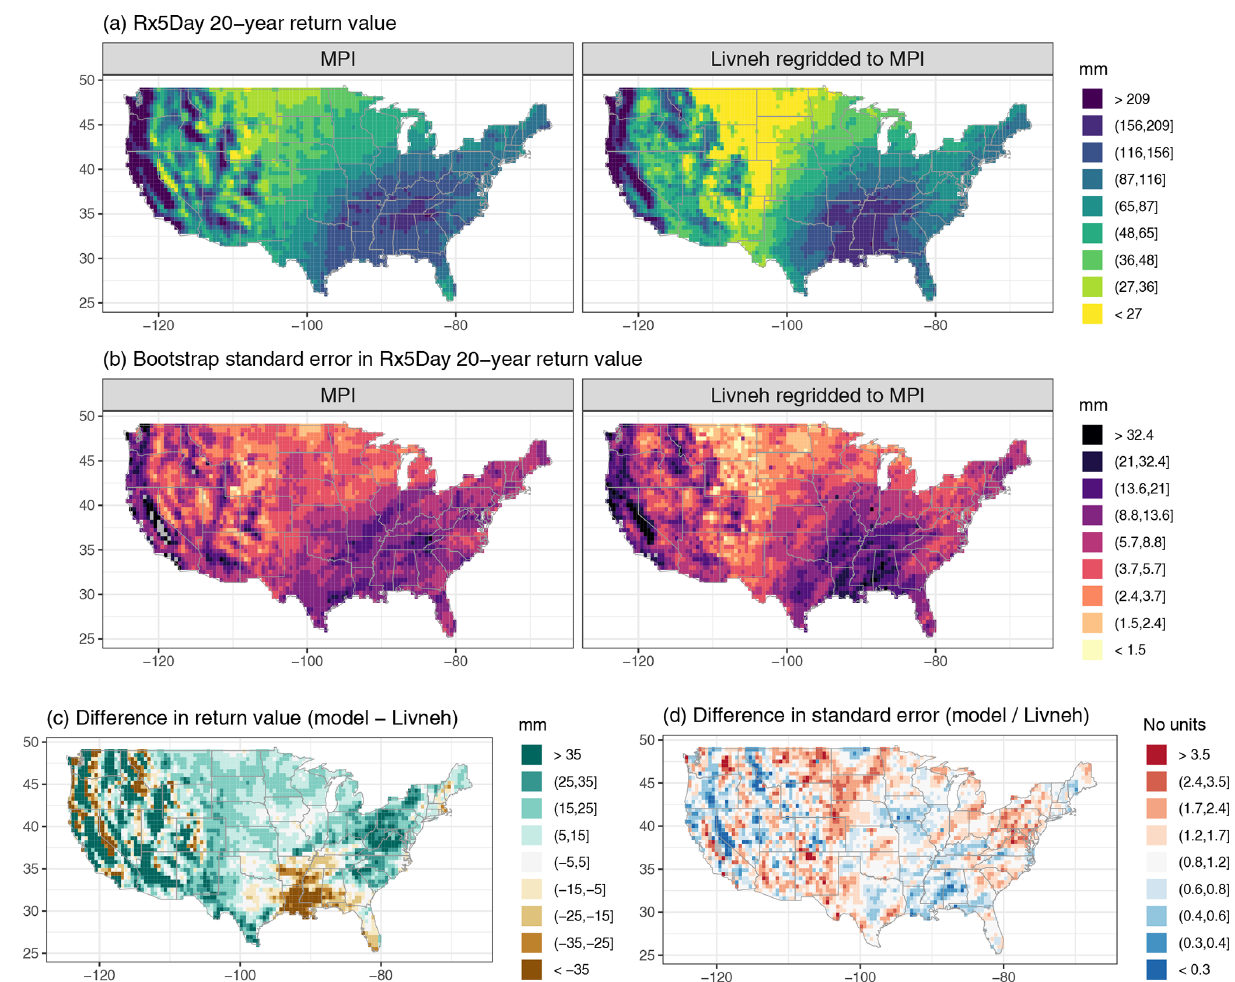
Figure A7. Wintertime (DJF) 20-year return values in Rx5Day (mm) for the MPI model and regridded L15 (a) , with the bootstrap standard error (mm; b ). Also shown is the difference in return values (model minus regridded L15) as well as the ratio of standard errors (model divided by regridded